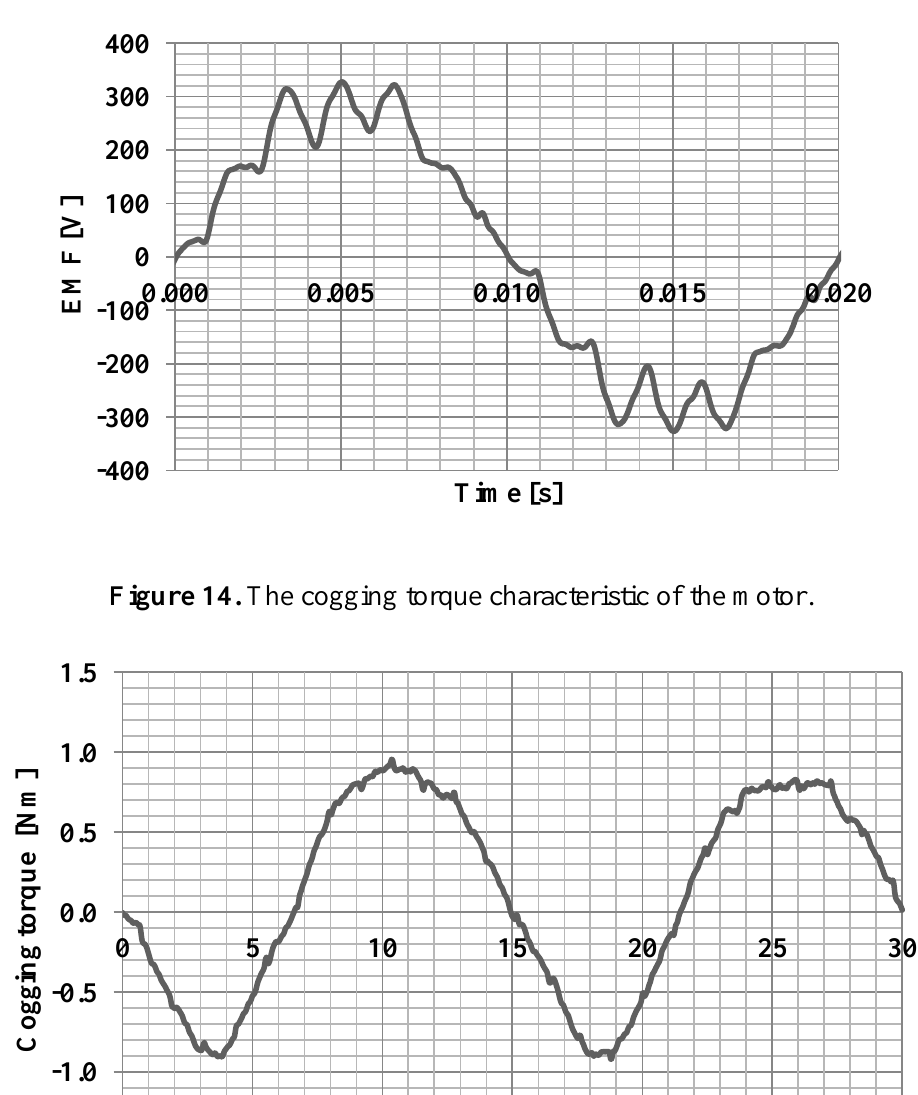
Figure 13. EMF characteristic of the motor in a steady state at a speed of 1500 rpm.